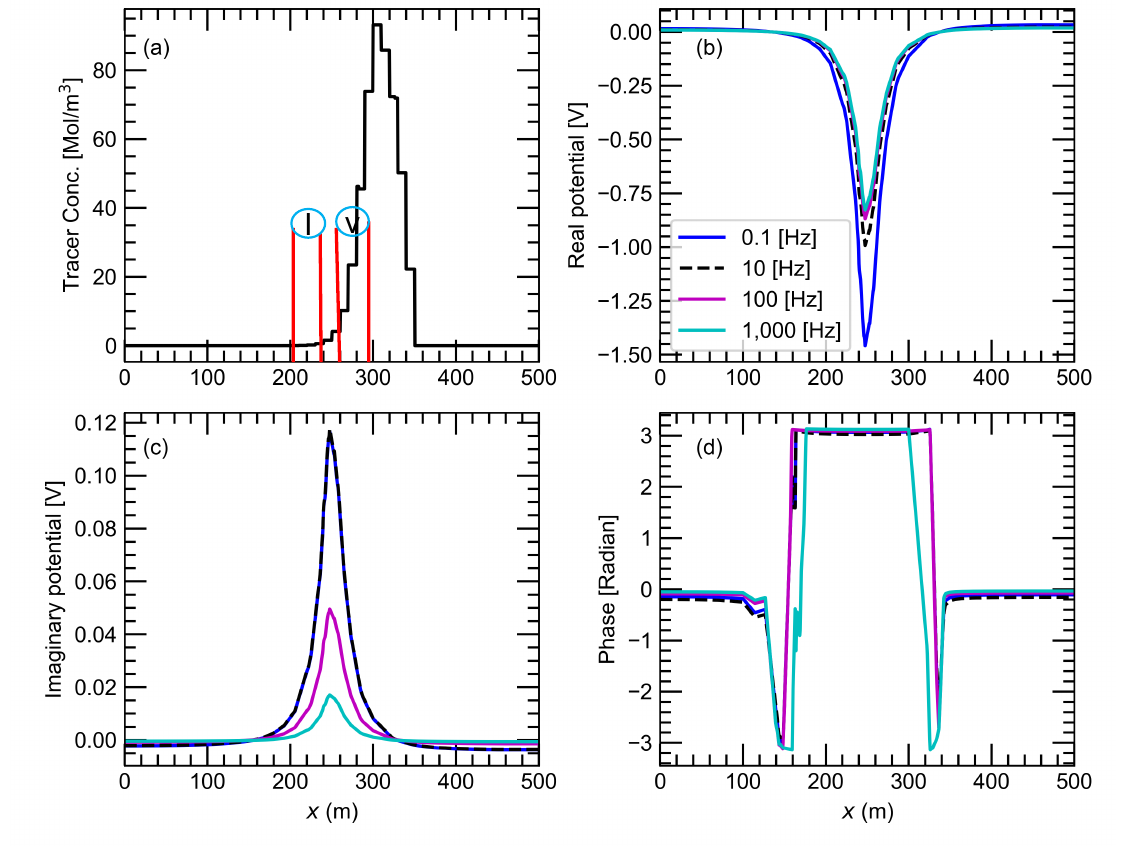
Figure 7. Distribution of ( a ) tracer concentration and ( b ) real potential, ( c ) imaginary component of complex potential, and ( d ) phase shift along the x -axis at y = 250m and z = −